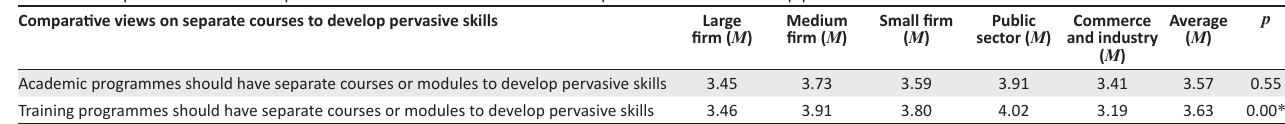
TABLE 6: Comparative results on aspirant chartered accountants’ views on separate courses to develop pervasive skills. Comparative views on separate courses to develop pervasive